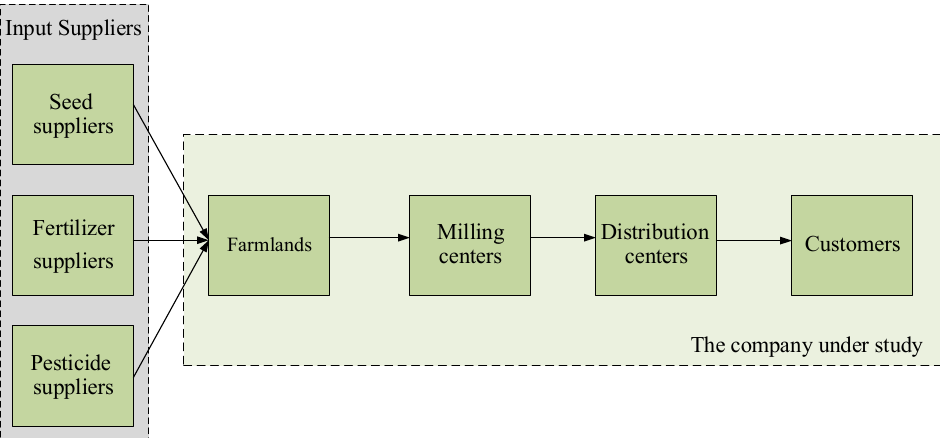
Fig. 1. The rice supply chain network of the company